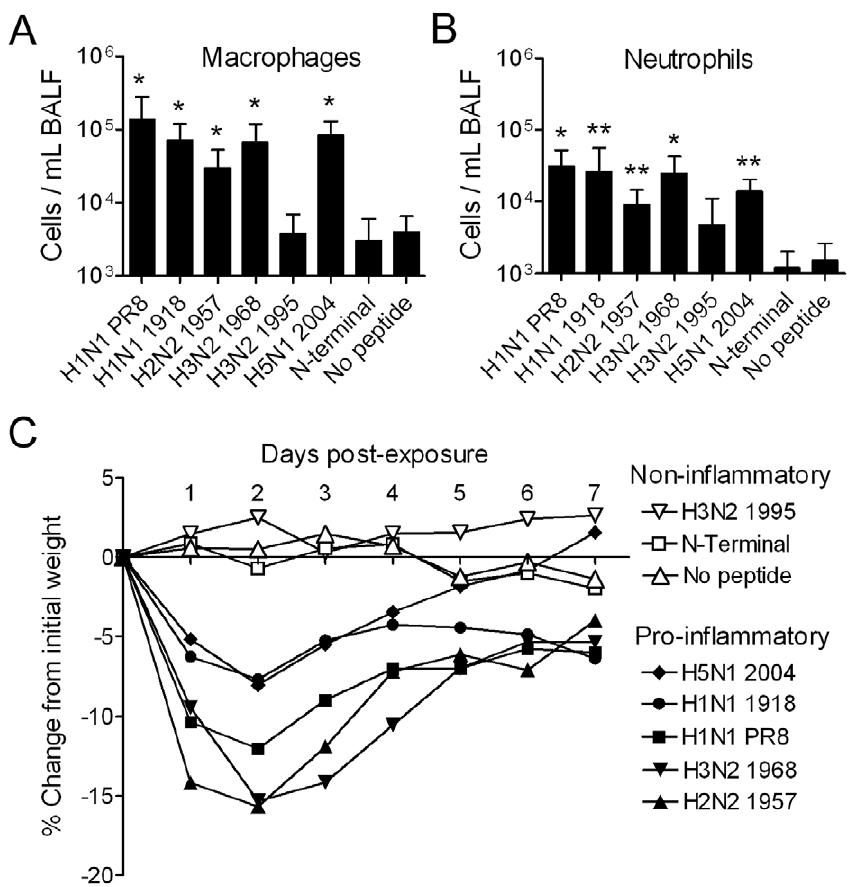
Figure 4. PB1-F2 peptides enhance inflammation in the lung. Groups of mice were exposed to a panel of peptides (100 mM final concentration, see Figure 1 for definitions) and euthanized 24 hours later. BAL fluid from the animals was assayed by flow-cytometry [10] for the mean number of A) macrophages and B) neutrophils compared to unexposed mice or mice exposed to an N-terminal control peptide. An asterisk (*) indicates a significant difference compared to the 1995 H3N2 peptide and controls by ANOVA (p , 0.05). A double asterisk (**) indicates a significant difference compared to the controls. Error bars indicate the standard deviation from the mean. C) In a separate set of experiments, mice exposed to peptide were monitored for overt signs of illness and percentage change from initial weight. For clarity, peptides are grouped by their inflammatory potential as determined in A & B.